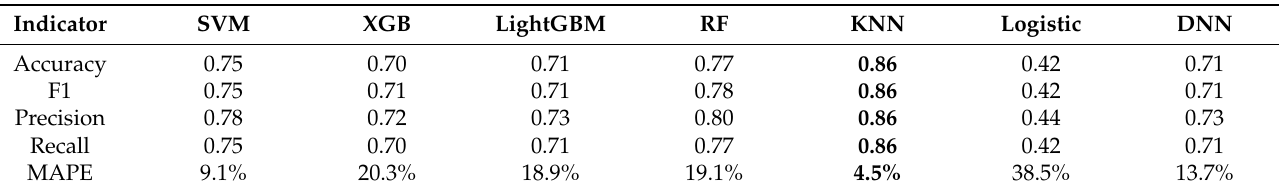
Table 2. Evaluation Results of Each Prediction